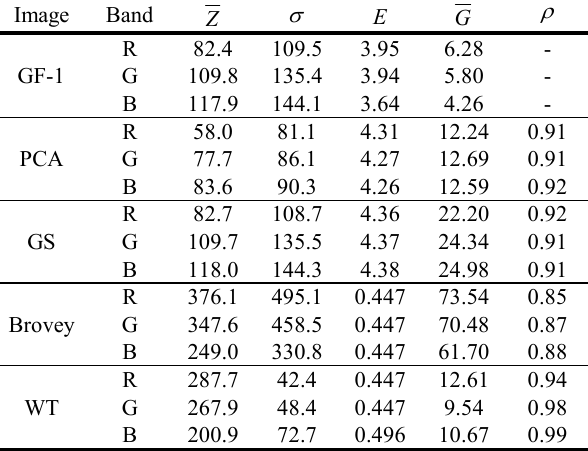
Table 3. The evaluation indicators for the fusion